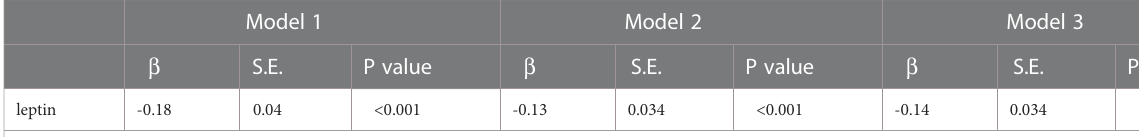
TABLE 3 Association between leptin and eGFR in multivariate linear